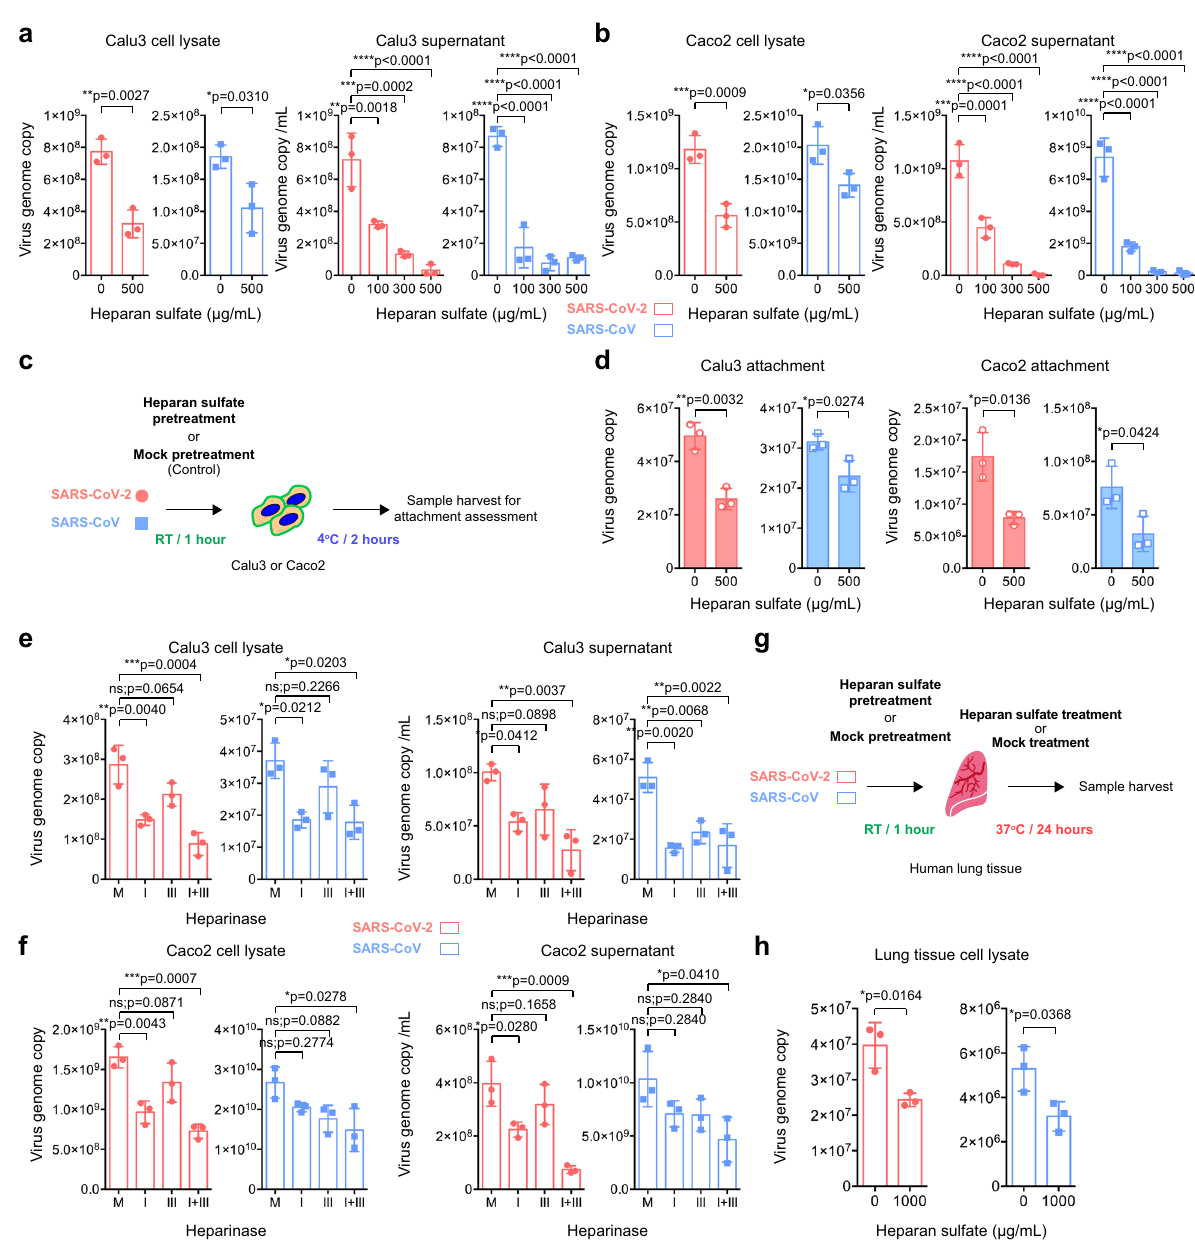
Fig. 1 Heparan sulfate (HS) serves as an attachment factor for SARS-CoV-2 infection. a – b Calu3 and Caco2 cells were inoculated with HS-pretreated SARS-CoV-2 or SARS-CoV at 0.2 MOI for 2 h at 37 °C. Cell lysates and supernatants were harvested at 24hpi and virus replication was determined with qRT-PCR ( n = 3). c Schematic of the attachment assay. d Calu3 and Caco2 cells were inoculated with HS-pretreated SARS-CoV-2 or SARS-CoV at 0.2 MOI for 2 h at 4 °C. Cell lysates were harvested after the 2 h incubation and virus attachment was determined with qRT-PCR ( n = 3). e – f Calu3 and Caco2 were pretreated with Heparinase I (4U/ml), Heparinase III (0.5U/ml) or both for 1 h at 37 °C, followed by virus infection at 0.2 MOI. Cell lysates and supernatants were harvested at 24hpi for qRT-PCR analysis ( n = 3). g – h Human lung tissues were challenged with HS-pretreated SARS-CoV-2 or SARS- CoV at an inoculum of 1 × 10 7 PFU/ml for 2 h. Tissues were harvested and homogenized at 24hpi for viral gene copy detection ( n = 3). Data represented mean and standard deviations from the indicated number of biological repeats. Statistical signi fi cance between groups was determined with one way- ANOVA ( a and b supernatant panels, e and f ) or two-sided unpaired Student ’ s t test ( a and b cell lysate panels, d and h ). * represented p < 0.05, ** represented p < 0.01, *** represented p < 0.001, **** represented p < 0.0001. ns not signi fi cant. Source data are provided as a Source Data fi